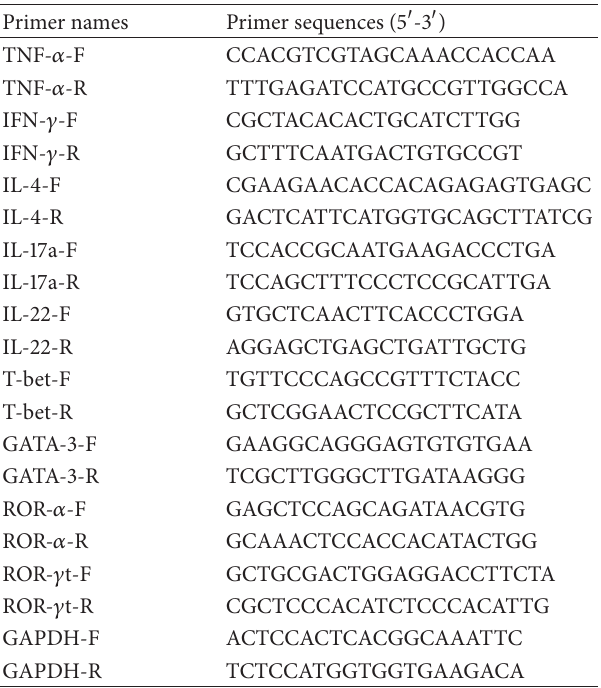
Table 3: The gene-specific primer pairs list in the